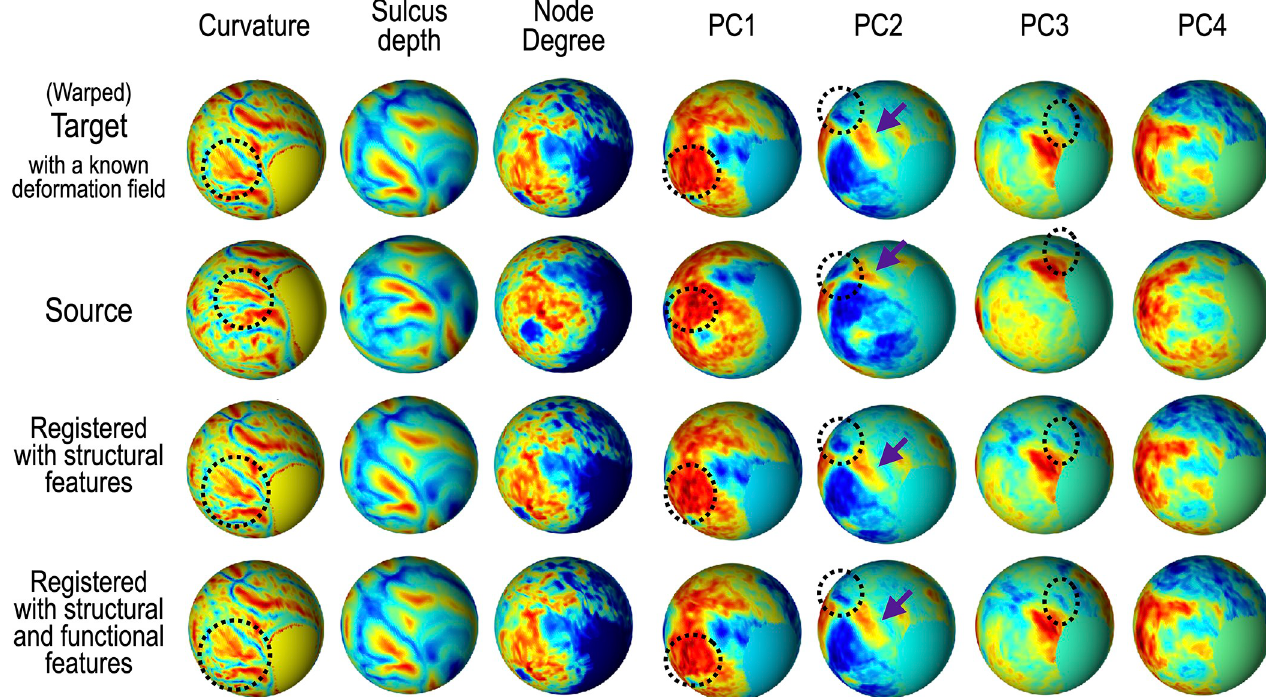
Fig 5. Spherical demons registration results of nonlinear warping simulation. Spheres on the top row show the target features (warped from the source sphere using a ground-truth deformation field). The spheres on the second row show the source features. The last two rows show the registration results only with structural features and with both structural and functional features, respectively. Warping with structural and functional properties makes the source sphere highly aligned with the target sphere.